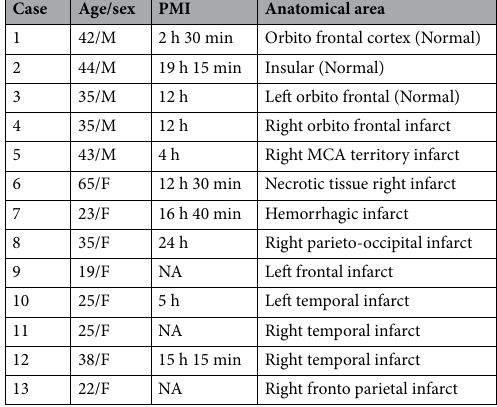
Table 1. Summary of the patient’s information. MCA middle cerebral artery, M male, F female, PMI post- mortem